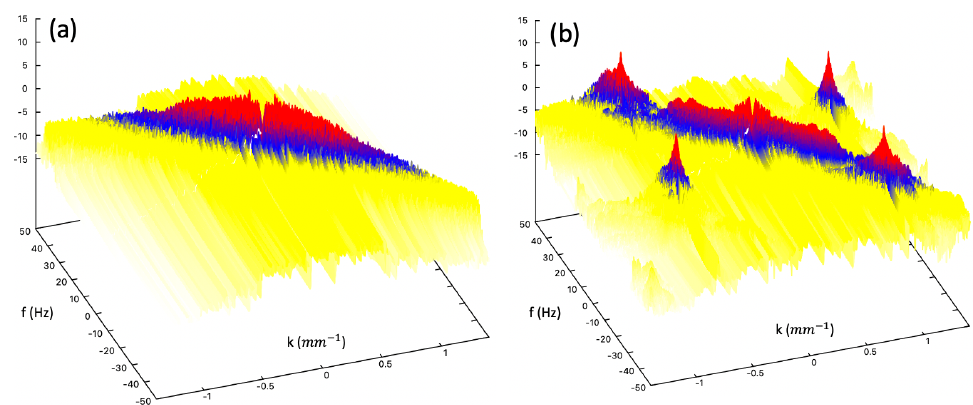
Figure 8. ( a ) Dispersion map obtained from the solution of Equation(1) in the absence of vibration for a 0.6mm water film on a θ = 3 o incline. ( b ) Dispersion map of the solution of Equation(1) when the inclined plane vibrated at f = 48Hz with the amplitude a = 0.8. The scaling for the vertical axis is in arbitrary logarithmic